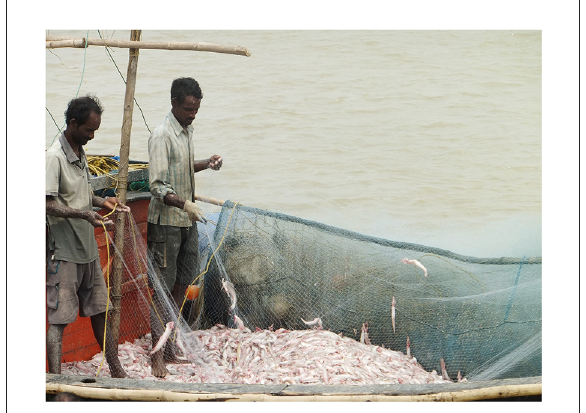
FIGURE6 Fishermen in Digha with fish catch using deep sea fishing trawlers. Source: Authors.